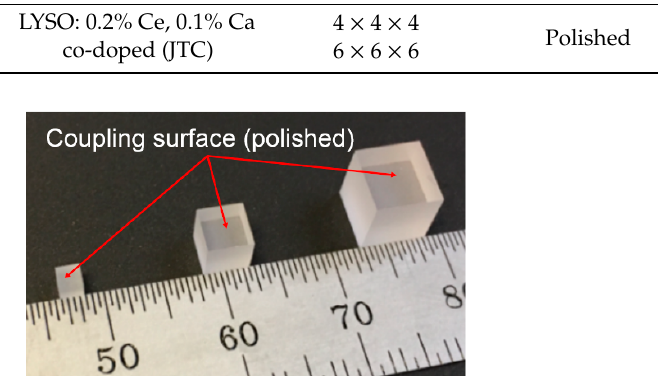
Figure 2. LYSO cubes with sizes of 2 × 2 × 2 mm 3 ( left ), 4 × 4 × 4 mm 3 ( middle ) and 6 × 6 × 6 mm 3 ( right ).